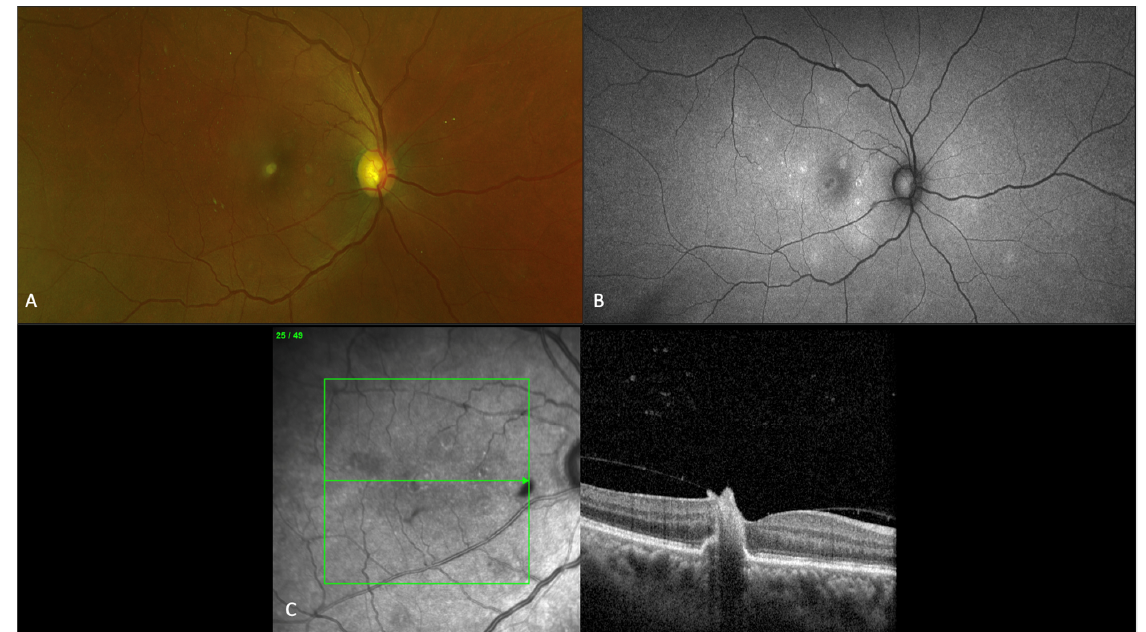
Figure 4. Imaging findings for a 56-year-old patient with fungal chorioretinitis, showing characteristic fundus, autofluorescence, and optical coherence tomography (OCT) macula findings. ( A ) Fundus photograph of right eye showing multiple small chorioretinal white lesions predominantly in the macula. ( B ) Fundus autofluorescence showing large area of hypoautofluoroescence in the fovea and multiple areas of scattered punctate hyperautofluoresence lesions in areas of early retinal pigment epithelium loss. ( C ) OCT macula findings over the foveal chorioretinal lesion depicting infiltration from choroid through retinal layers into the vitreous with focal areas of traction.